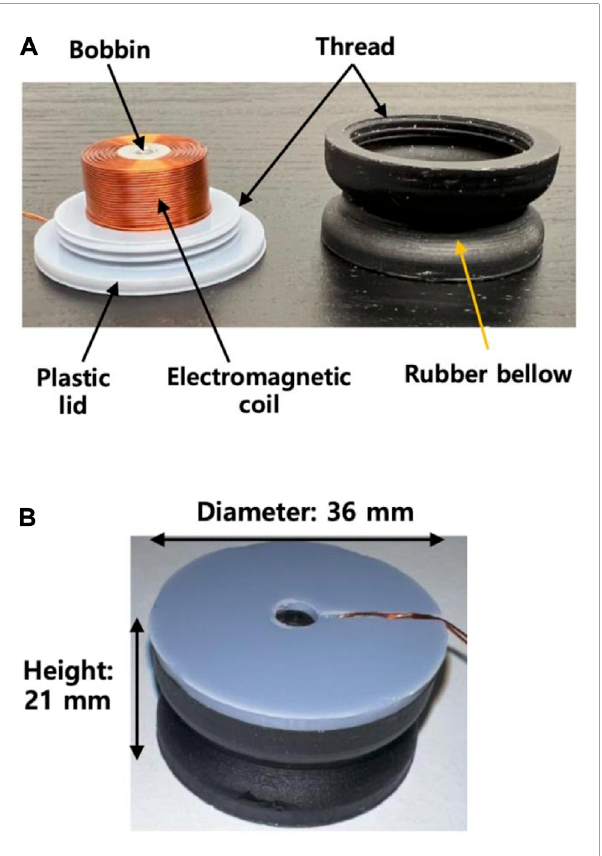
FIGURE 2 Photograph of the fabricated 3D-printed MRVI. (A) Parts. (B) Assembly.